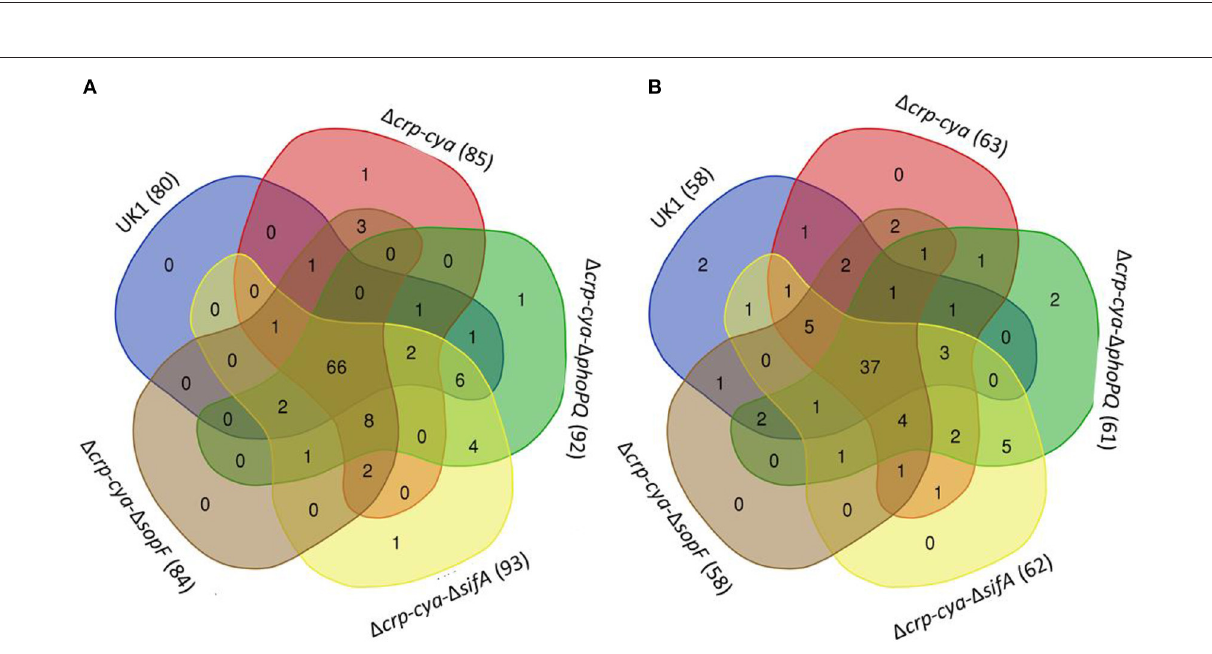
Frontiers in Microbiology | www.frontiersin.org